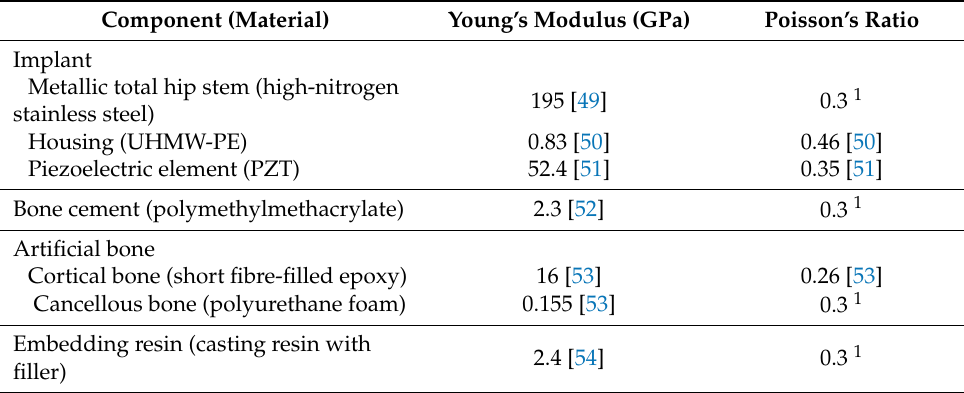
Table 2. Material